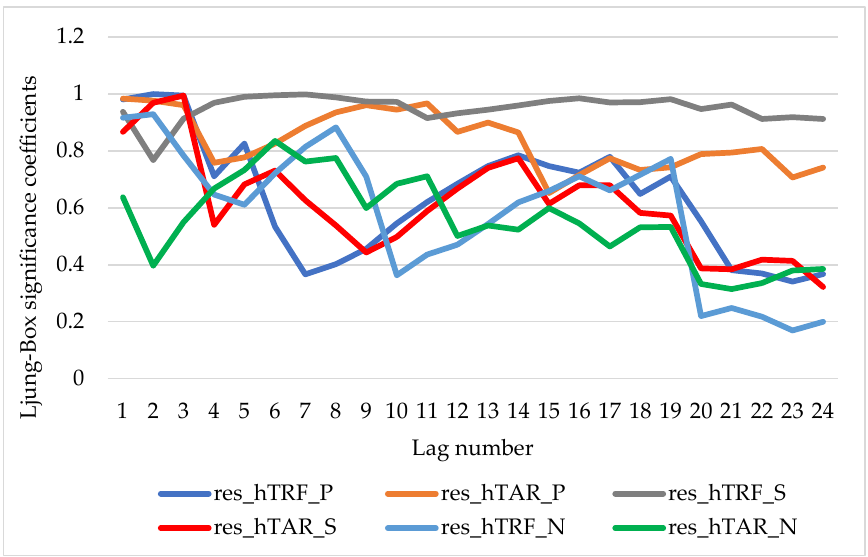
Figure 6. Significance values of Ljung-Box coefficients for residuals of the initial hybrid test models.